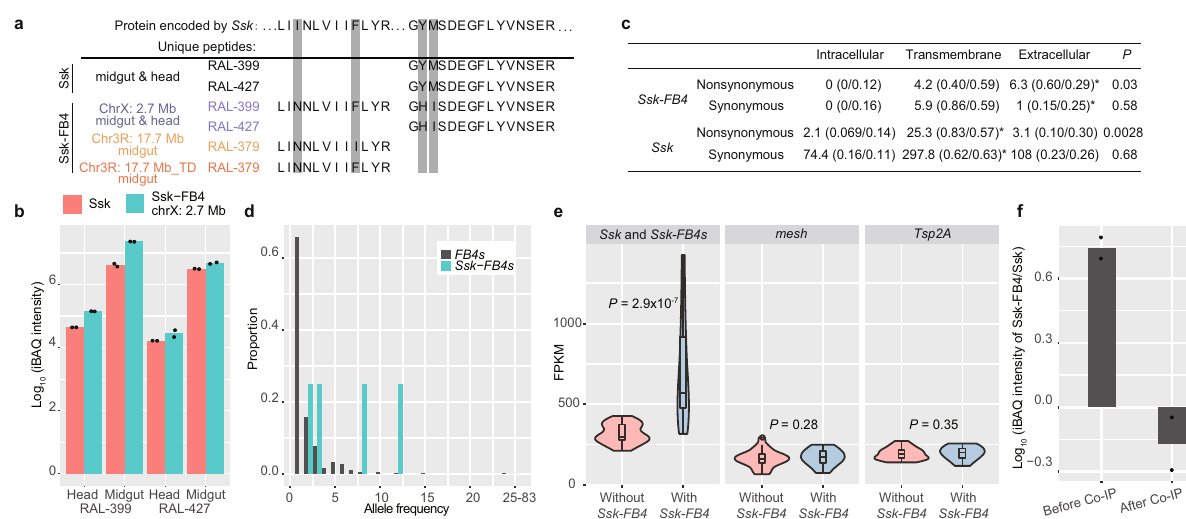
Fig. 5 Ssk-FB4s represent a young rapidly evolving protein family. a Unique peptides of Ssk and Ssk-FB4s. Three Ssk-FB4s are color-coded as in Fig. 3c. The top row shows the sequence of Ssk, whereas the distinct residues between Ssk and individual Ssk-FB4s are marked in gray. b Abundance (intensity- based absolute quanti fi cation, iBAQ) of Ssk and X-linked Ssk-FB4 in the RAL-399 line. Dots indicate 2 technically independent replicates. c Numbers of nonsynonymous and synonymous changes across three functional regions in Ssk-FB4s and Ssk . The upper polymorphism data are based on the codon-level alignment of Ssk-FB4s (Supplementary Fig. 14a). The lower divergence data of Ssk are based on the whole Drosophila genus (Supplementary Fig. 14e). Each cell is shown as the “ number of changed sites (observed/expected proportion of changed sites) ” . * P -values were calculated for the regions of interest with the one-sided proportion test. d Allele frequency spectrum of FB4s and Ssk-FB4s in 83 DGRP lines. e Transcription of Ssk , mesh , and Tsp2A in the gut across lines with ( n = 15 samples) or without Ssk-FB4s ( n = 23 samples). The distribution is shown as violin plots in Fig. 2f. Because the expression pro fi les of Ssk and Ssk-FB4s are largely similar, we simply merged the expression of Ssk and Ssk-FB4s . The one-sided Wilcoxon rank-sum test was used to calculate the P - value. f Relative abundance of Ssk and Ssk-FB4 in RAL-399 cells before and after co-immunoprecipitation with an antibody against Mesh. Dots indicate two biologically independent Ssk -like gene structure for Ssk - FB4 at chr3R: 17.7 Mb and a